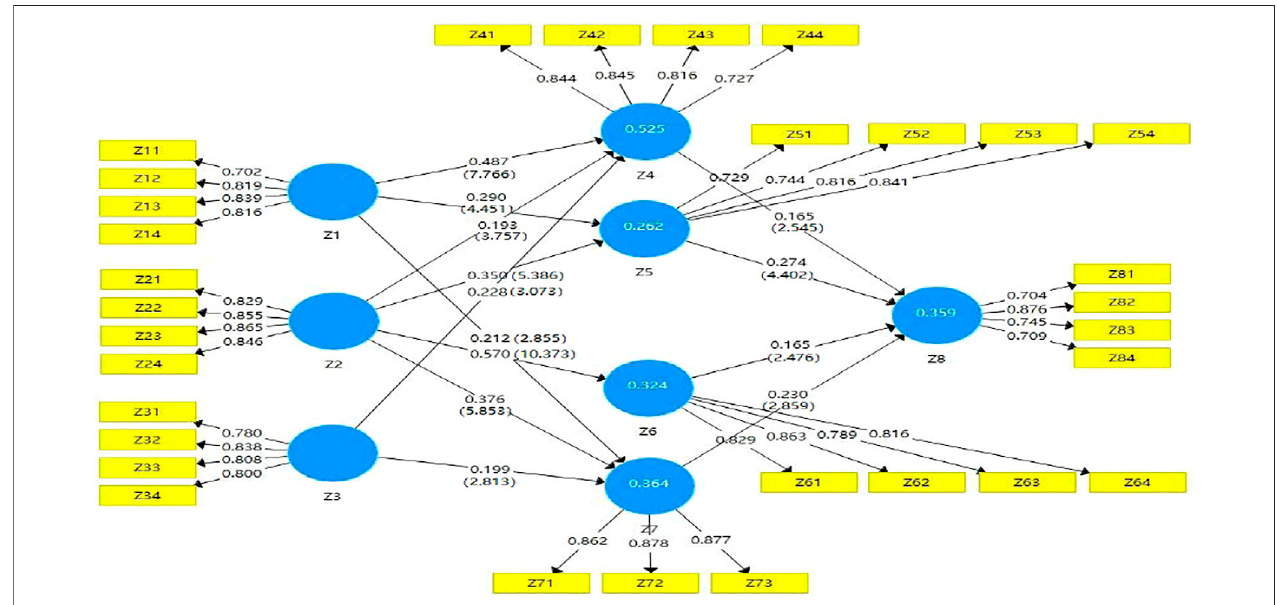
FIGURE 5 | PLS-SEM estimation results.